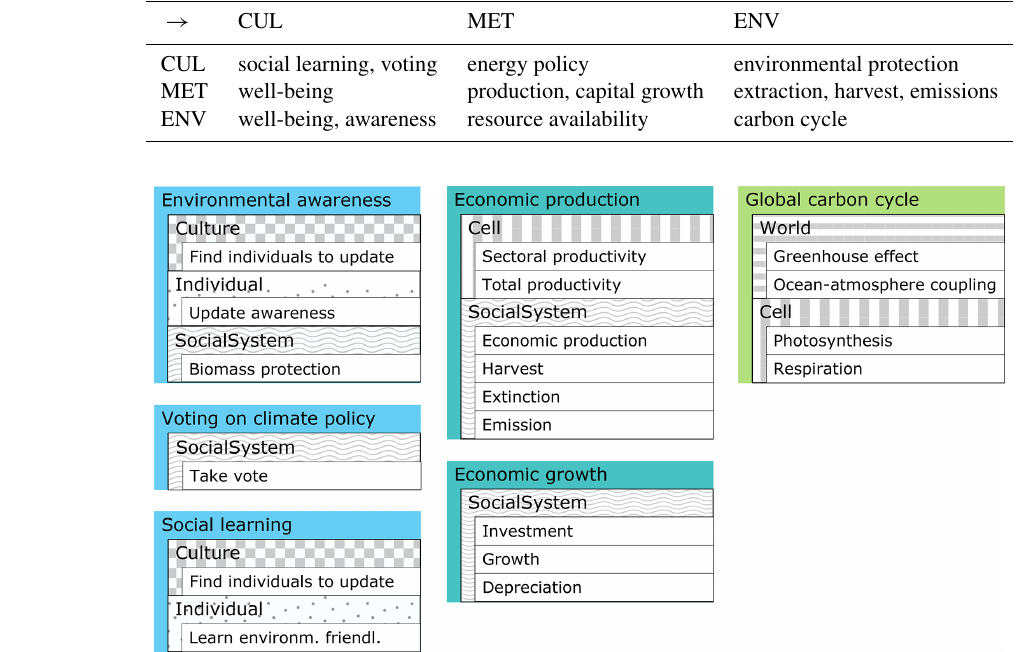
Figure 4. Components, entity types and processes of the example model. Each box represents a model component that contributes several processes (white bars) to different entity types and process taxa (differently hashed